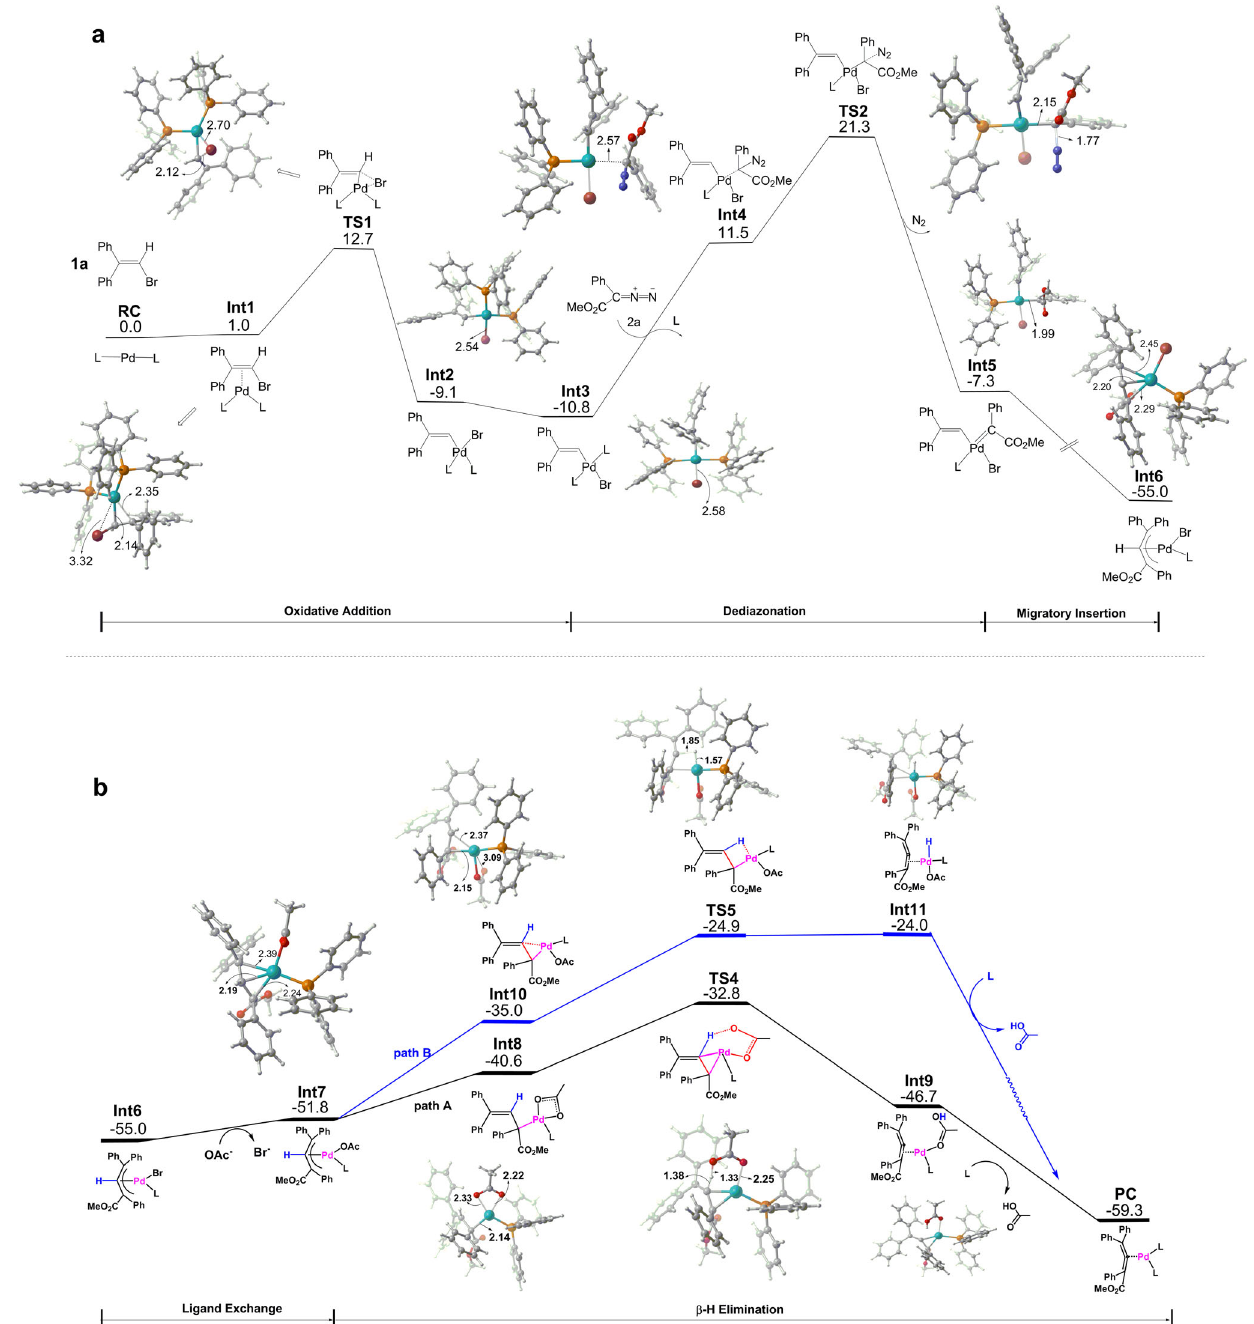
Fig. 9 Energy pro fi les and geometries of key species for the tentative reaction pathways. a Energy pro fi les and geometries of key species for the formation of allylpalladium species. b Energy pro fi les and geometries of key species for β -hydrogen elimination mechanism. All results are calculated at the SMD (tetrahydrofuran) M06/def2-TZVP//B3LYP/6-31G(d)(LANL2DZ) level of theory. Relative free energies are in kcal/mol and bond lengths are in